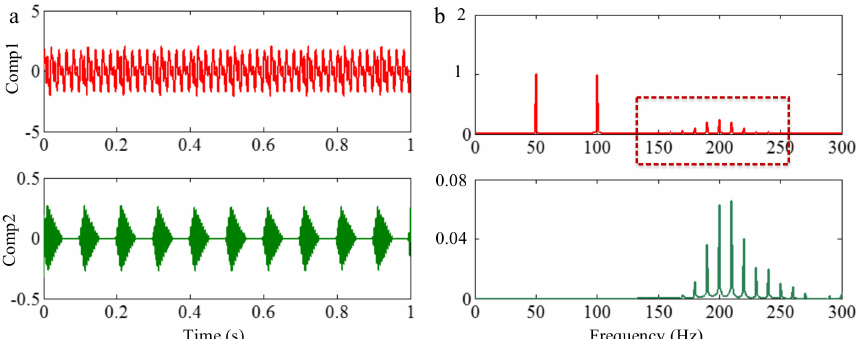
Figure 32. Each component of the sample signal f sig 7 : ( a ) the waveform and ( b ) the Fourier spectrum.